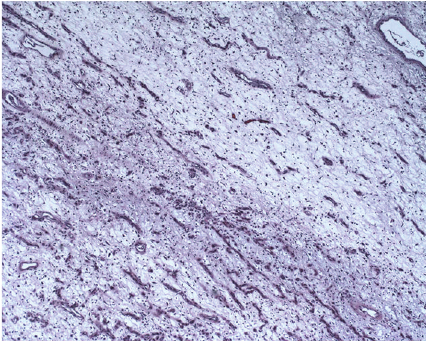
Figure 10: Low power of inflammatory fibroid polyp (5x). There is fibrovascular proliferation with edematous and myxoid back-